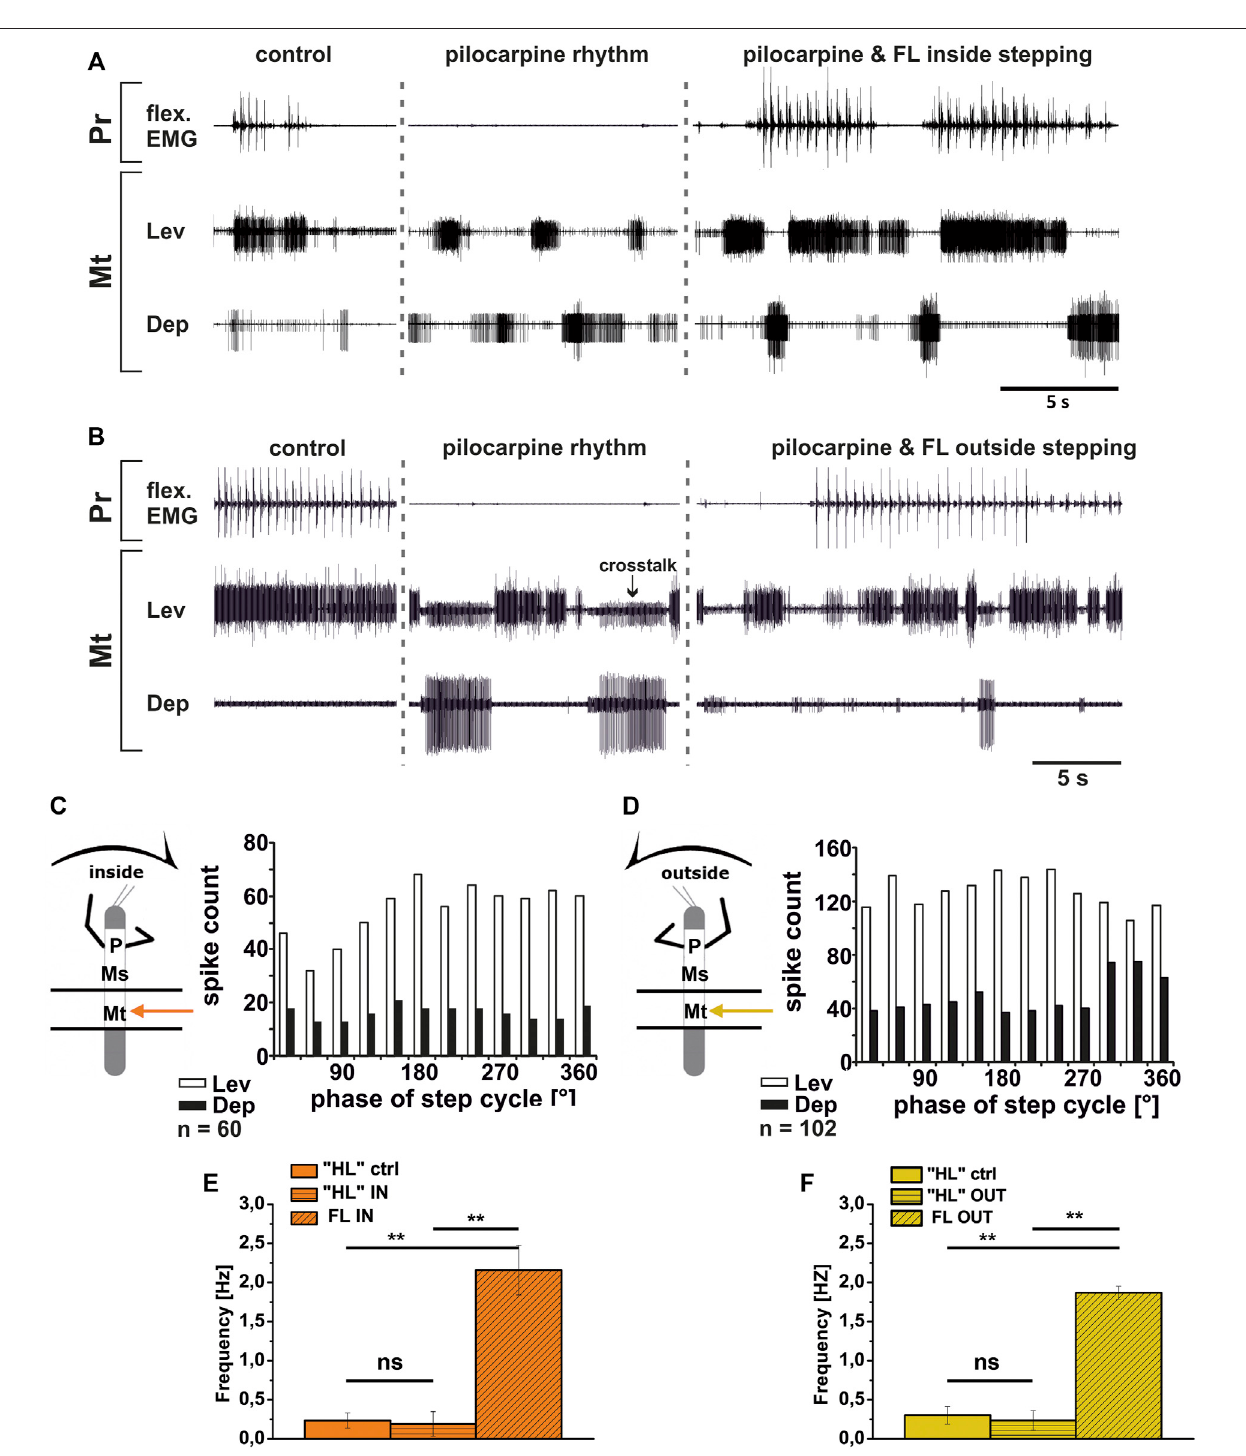
FIGURE10| Motoroutputof levator (Lev)and depressor (Dep) coxae MNpoolsinthepilocarpineactivateddeafferentedmetathoracicganglion(Mt)duringfrontleg (FL) inside (A,C) and outside (B,D) stepping; (A,B) . FL Flexor EMG ( “ fl ex ” , top), together with extracellular recordings of the ipsilateral metathoracic levator (C1 nerve, secondtrace)anddepressor(C2nerve,thirdtrace)nerveduringcontrolinside (A) oroutside (B) steps,inpilocarpinew/oFLsteps,andduringinsideandoutsidestepping under pilocarpine application, respectively; (C,D) . Phase histograms of levator and depressor nerve activity under pilocarpine during inside (C) and outside (D) stepping, with respect to the FL step cycle; (E,F) . Comparison of pilocarpine C1 control Burst frequency ( “ HL ” ctrl) with deafferent HL-segment C1 burst frequency ( “ HL ” IN/OUT)duringinside/outsidestepsofthefrontlegs(FLIN/OUT)from14inside,and7outsidewalkingsequencesin4,respectivelyThreeexperiments(signi fi cance level < 0.01); n = number of analyzed steps. ns: not signi fi cant; Pr: prothoracic segment. The sketch indicates a stick insect with front legs in a fl exed (inside) or stretched (outside)position,andthearrowaboveindicatingtheturningdirection,thearrowonthesidetherecordedthoracicsegment.Theblackbarssymbolizethevaselinebarrier.